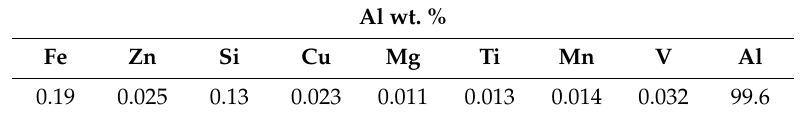
Table 2. Chemical composition of Al sheet (%)